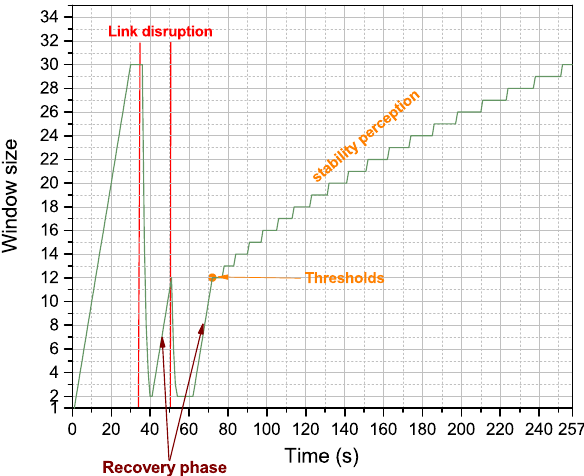
Figure 3. Behaviourof the windows